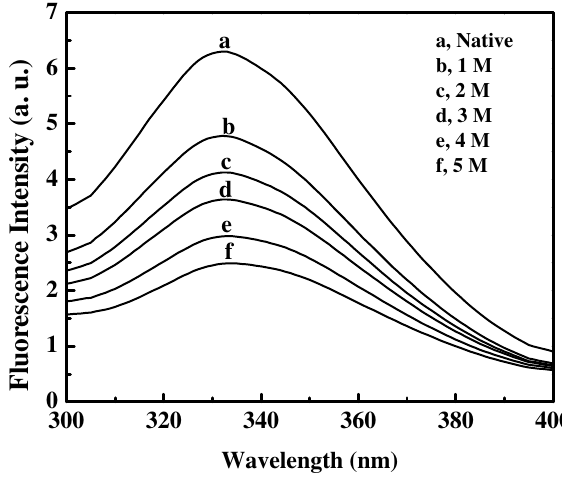
Figure 1 . Fluorescence spectra of sLP at varying concentrations of